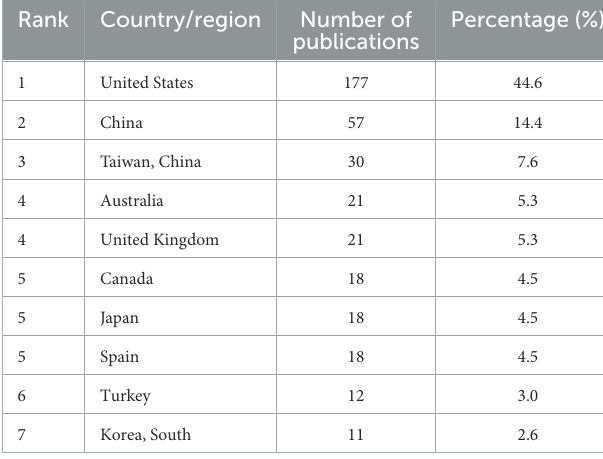
TABLE 3 Top 10 country/region by the number of